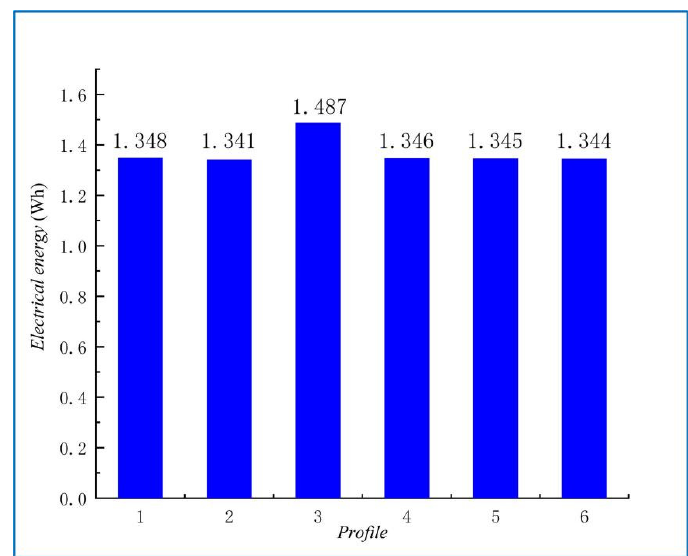
Figure 15. The power generation in the six profiles during the sea trial. Table 2. The performance parameters of the PCM-based electrical energy storage vehicles.